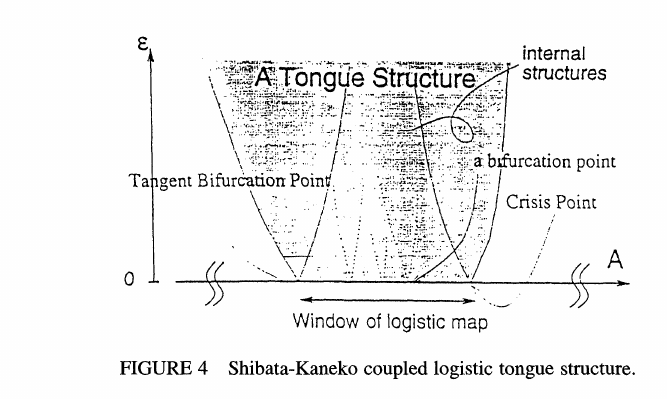
FIGURE 4 Shibata-Kaneko coupled logistic tongue